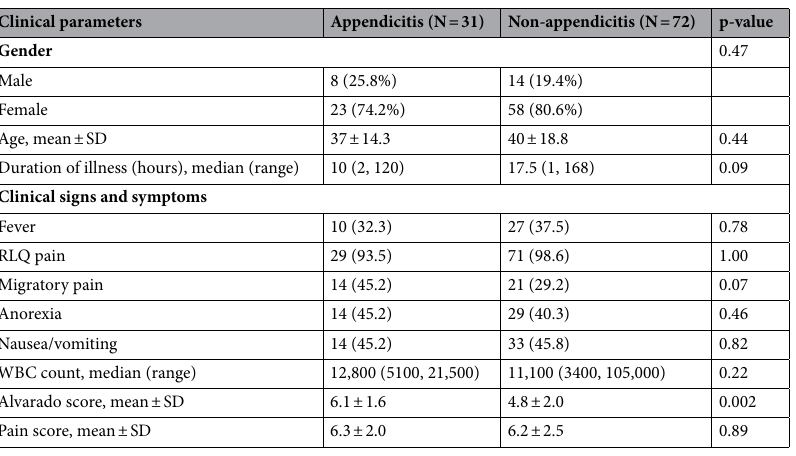
Table 1. Comparison of clinical parameters between appendicitis and non-appendicitis groups. RLQ: right lower quadrant, WBC: white blood cell.